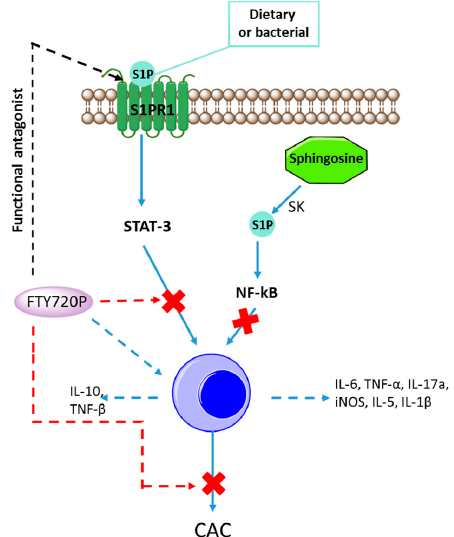
Figure 3. Immunomodulatory activity of FTY720P. FTY720P as functional antagonist indirectly diminishes STAT-3 signaling by binding to S1PR1 on the cell surface, resulting in the internalization of S1PR1, and preventing S1P from binding to and activating this receptor. Binding of FTY720P to the receptor thus causes the receptor to be sequestered inside the cell, out of reach of S1P. Solid arrows indicate S1P-dependent signaling pathways; dashed arrows indicate the impact of functional antagonist—FTYY720P on signaling pathways. Abbreviations: S1P—sphingosine-1-phosphate; S1PR1—sphingosine-1-phosphate receptor1; FTY720P—fingolimod phosphate ( S )-enantiomer; SK—sphingosine kinase; STAT3—signal transducer and activator of transcription 3; NF κ B—nuclear factor kappa-light-chain-enhancer of activated B cells; CAC—colitis and cancer; red cross means that this pathway is inhibited.